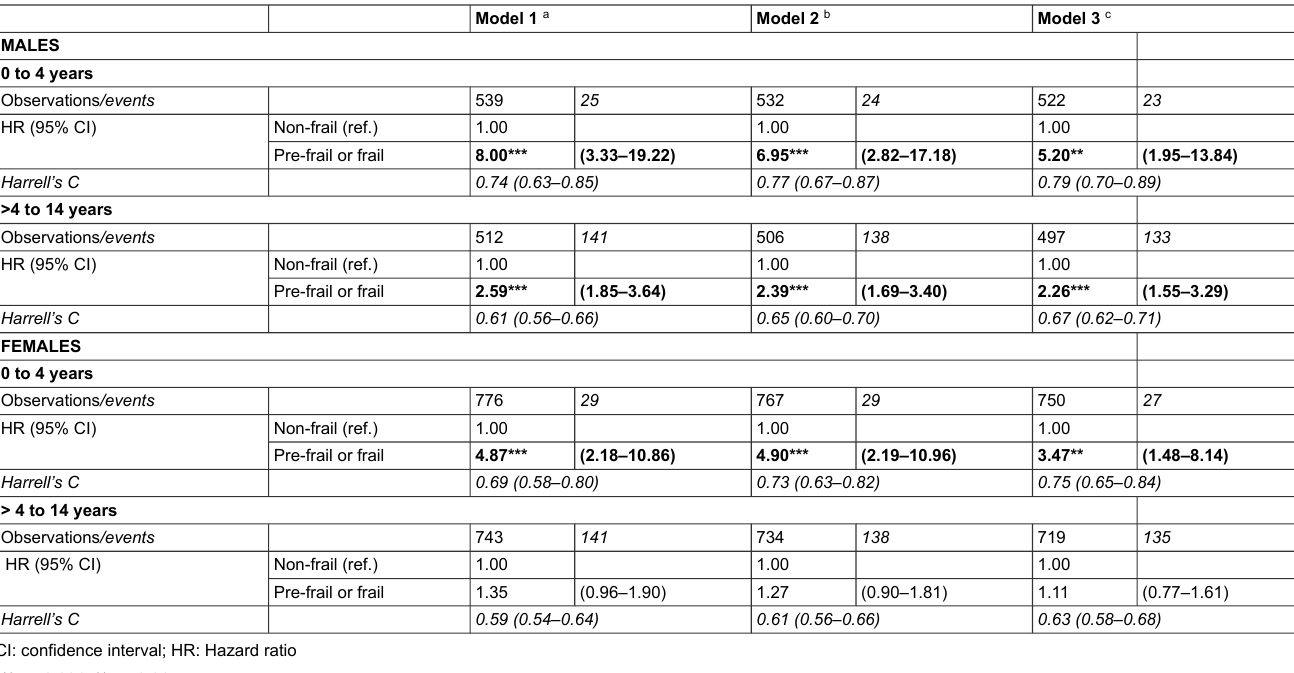
Table 2: Adjusted effect of pre-frailty or frailty at age 66 to 71 on mortality, by sex and follow-up period, Cox regression